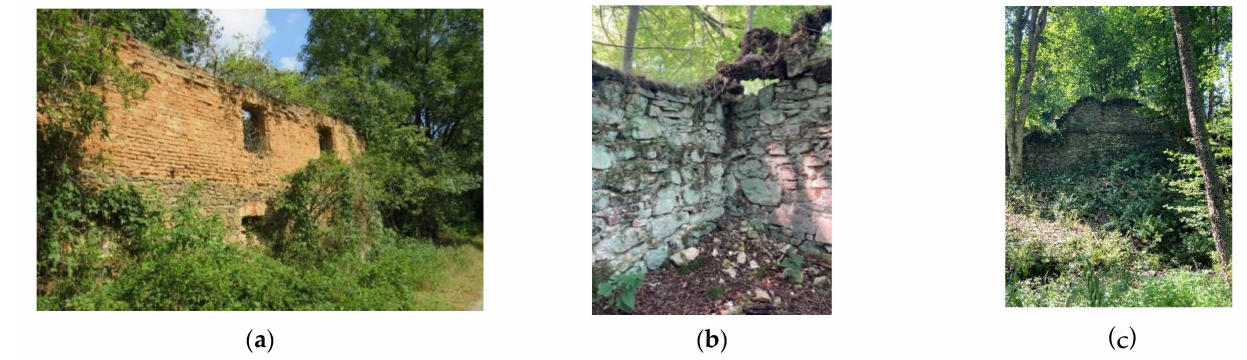
Figure 7. Ruins of buildings: ( a ) Pelhˇrimovy 50.1784936 N, 17.6598617 E; ( b ) Hraniˇcky 50.3106700 N, 16.9746497 E; ( c ) Libav á 49.7012961 N, 17.5890353